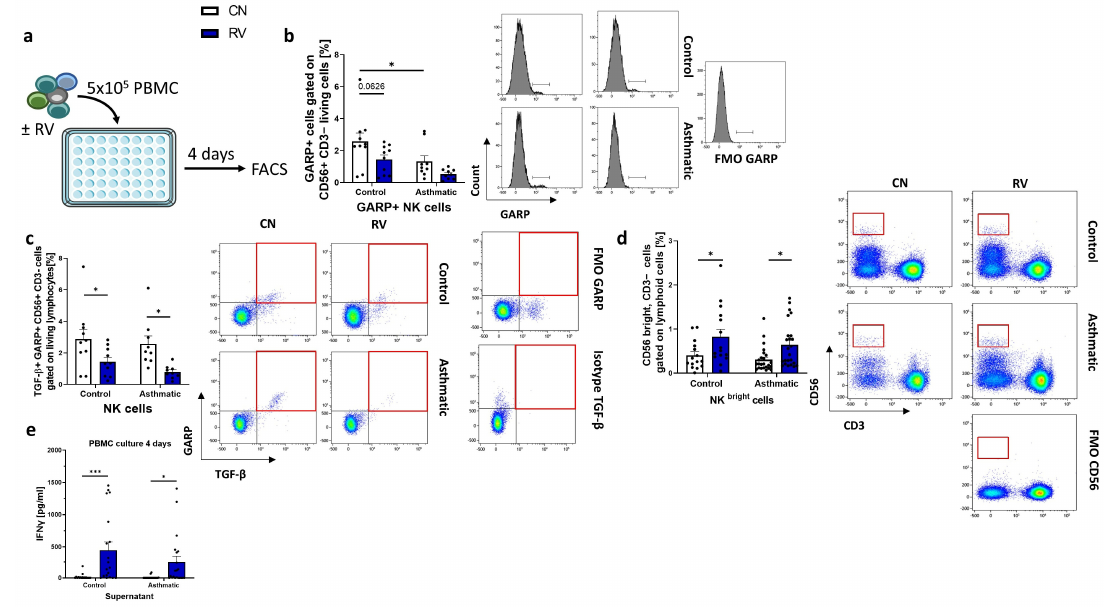
Figure 3. NK cells produce less TGF- β upon rhinovirus infection. ( a ) Experimental design. ( b ) Flow cytometry analysis of GARP-positive NK cells ( n = 10, 9, 10, 9). ( c ) Flow cytometry analysis of intracellular TGF- β + GARP+ NK cells. A representative dot plot for each group is shown ( n = 10, 9, 10, 9). ( d ) Flow cytometry analysis of CD56 bright NK cells ( n = 15, 24, 15, 24). ( e ) IFN γ ELISA of supernatants from CN and RV conditions ( n = 19, 22, 19, 22). Data are shown as Mean+SEM. * p < 0.05, *** p <